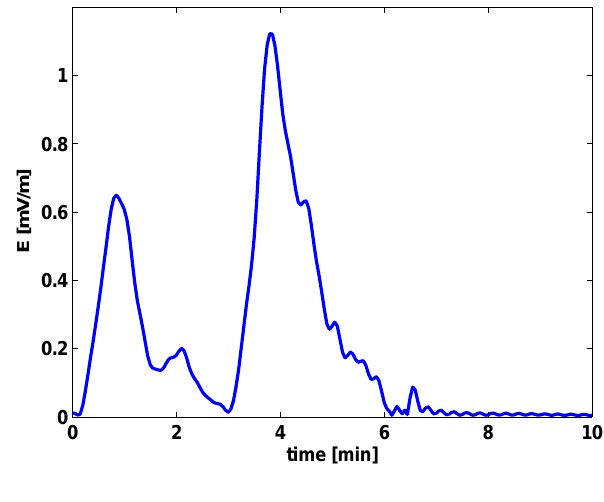
Fig. 8. Distribution of the standard deviation StD as function of the X-line location for reconstruction variant (1).